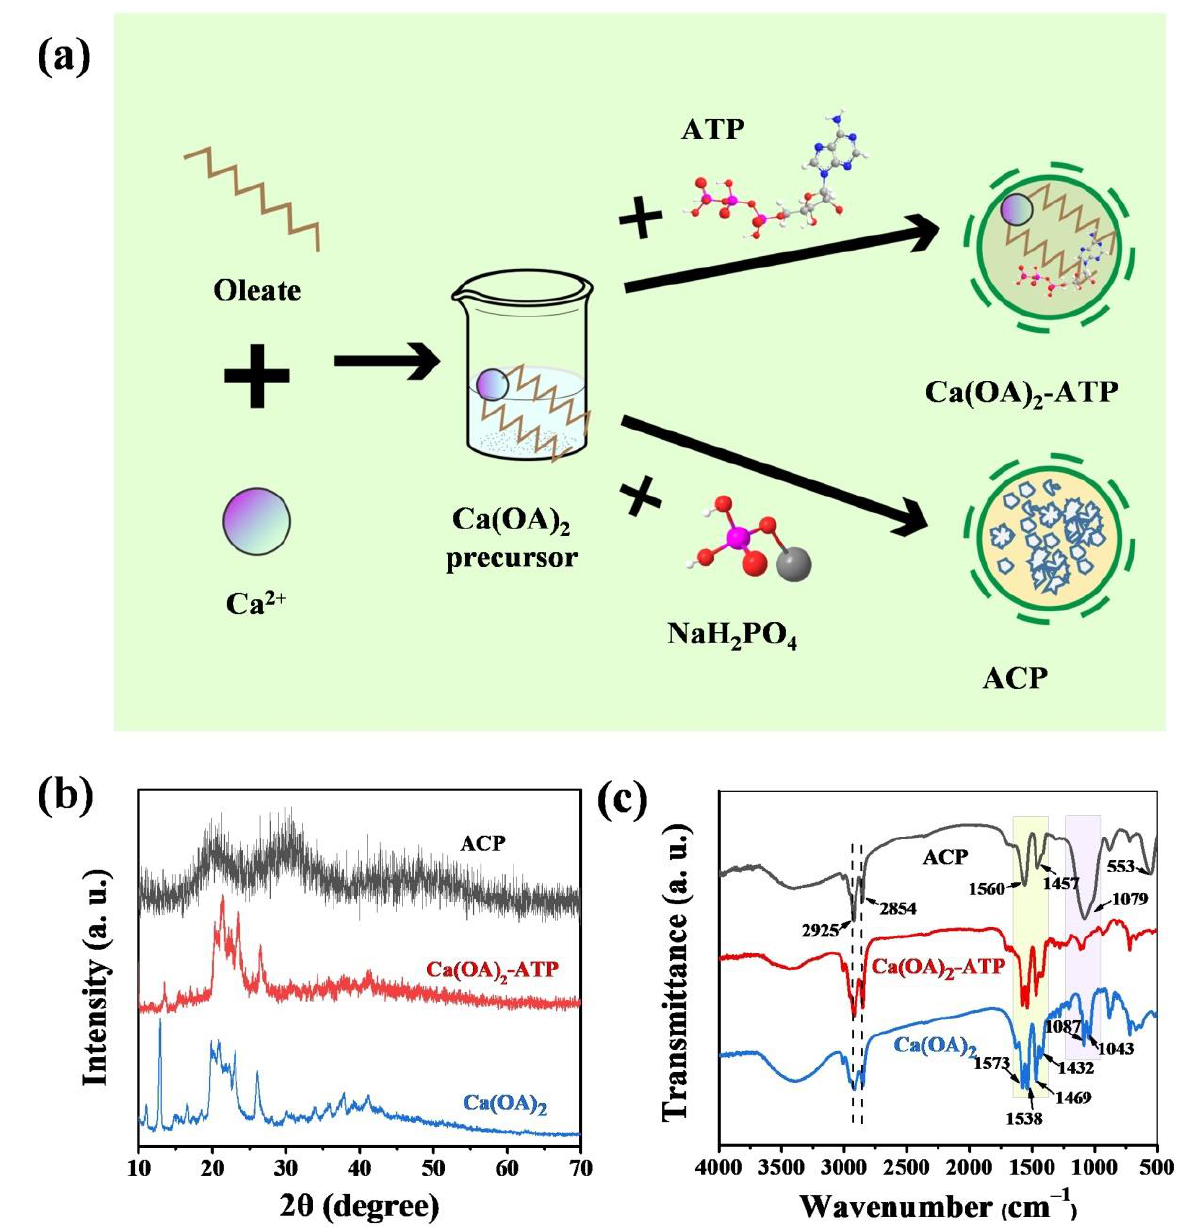
Figure 9. ( a ) Schematic illustration of the initial aqueous reaction system containing Na 2 ATP or NaH 2 PO 4 ·2H 2 O as the phosphorus source at room temperature without microwave hydrothermal treatment. ( b , c ) XRD patterns ( b ) and FTIR spectra ( c ) of calcium oleate (Ca(OA) 2 ) precursor, and the products after mixing calcium oleate precursor with the phosphorus source ATP or NaH 2 PO 4 · 2H 2 O in aqueous solution at room temperature.